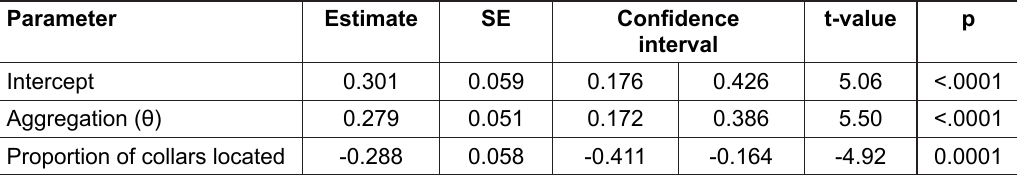
Table 3. Regression analysis results for factors affecting the precision of post-calving survey estimates as indicated by the coefficient of variation for caribou herds in the Northwest Territories and Nunavut, Canada,